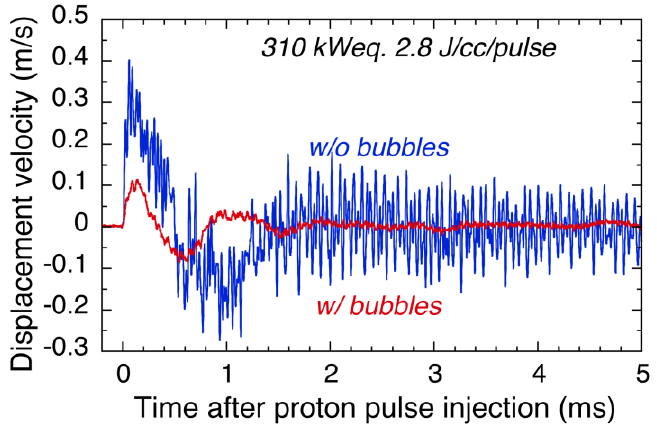
Figure 6. Time histories of the displacement velocity of the mercury target vessel measured with LDV system. Time 0 designates the proton impact on the target. Blue and red lines represent the data without and with injecting gas microbubbles, respectively.